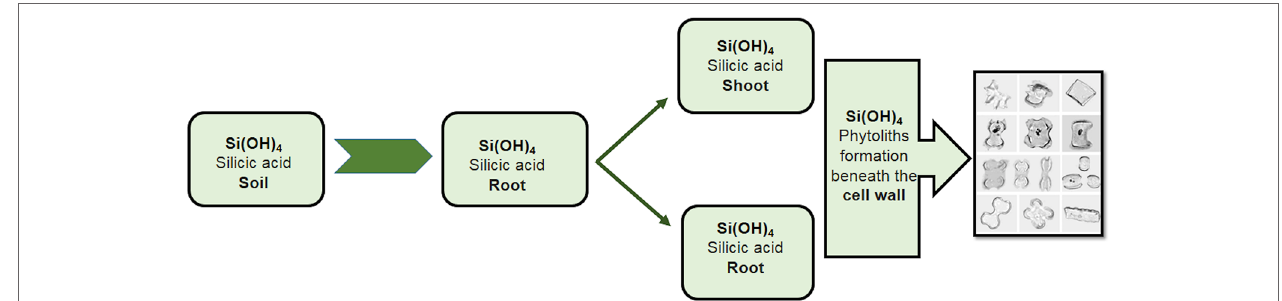
FIGURe 5 | Accumulation of Si in different parts of plants. Silicon accumulates in the form of phytoliths or discrete silica bodies in different parts of a plant, e.g. the roots, leaves, and stems. This deposition takes place beneath the cell wall of the roots, where the discrete bodies of Si bind with the Na + , resulting in the increased uptake of K + and the reduced transport of Na + to the upper regions of the